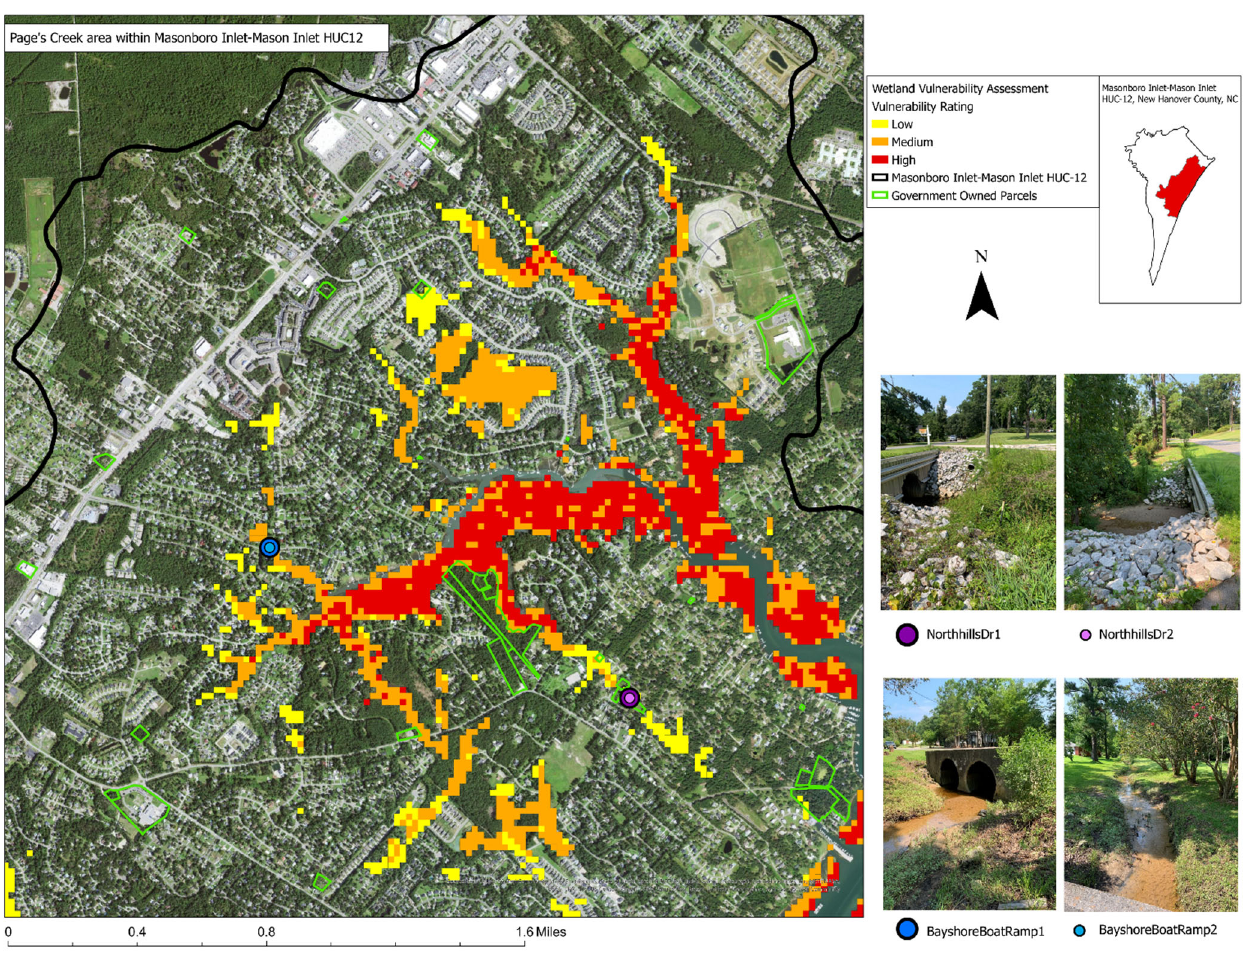
Figure 6. Wetland vulnerability assessment results, government-owned parcels, and locations identified in the field during site visits in the Page’s Creek area within the Masonboro Island–Mason Inlet subwatershed, NC overlaid on NAIP imagery.